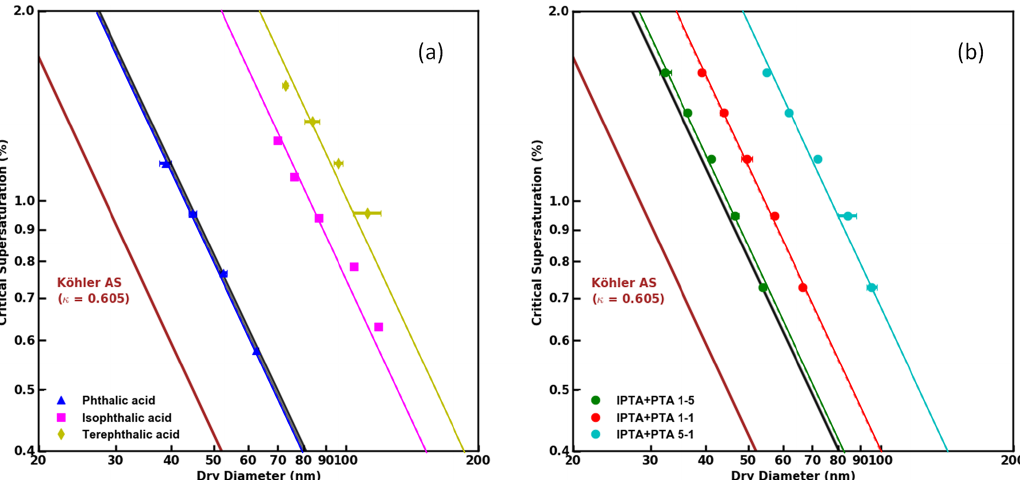
Figure 2. (a) S vs. D dry , c data obtained from supersaturated CCN measurements of pure phthalic acid (PTA), isophthalic acid (IPTA) and terephthalic acid (TPTA). (b) S vs. D dry , c data obtained from supersaturated CCN measurements of internal mixtures of PTA and IPTA. The mixtures studied shown in this plot are 5 : 1, 1 : 1 and 1 : 5 by mass of PTA. The solid brown line in both subplots corresponds to ammonium sulfate and was used for CCNC calibration. The solid black lines were generated using the ideal Köhler theory (KT) for the respective samples, and the dashed colored lines are the KT fits obtained using the measured CCN data of each sample.